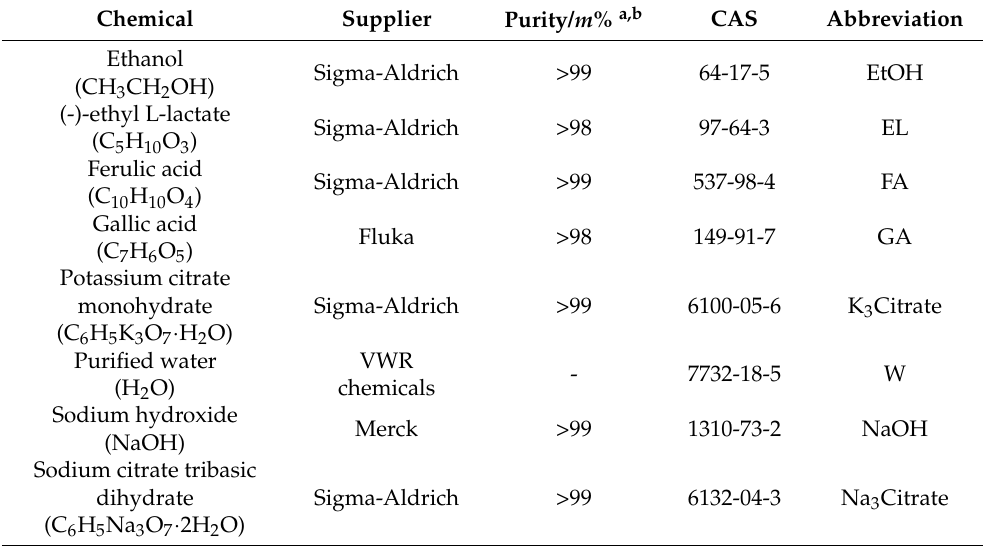
Table 1. List of chemicals used in this work, with respective chemical formula, supplier, purity, CAS number and